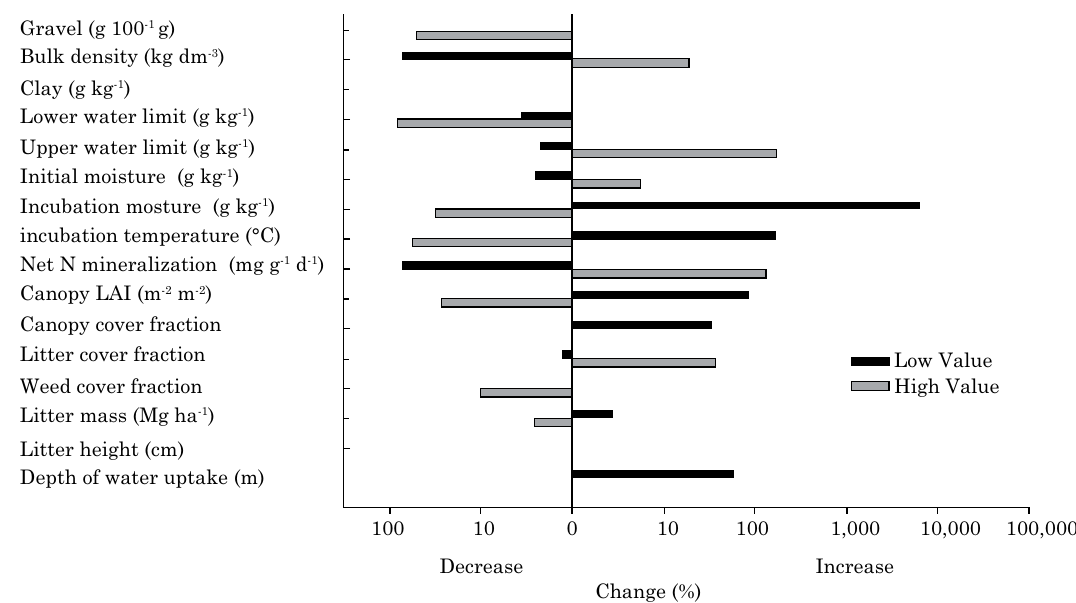
figure 5. sensitivity of predicted NNm rates in relation to single-factor variations in input parameters. Where values seem to be missing, the change in input parameter induced no change in output